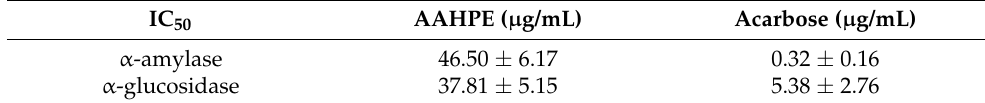
Figure 1. ( a ) α -amylase and ( b ) α -glucosidase inhibitory activity of AAHPE, using acarbose as a positive control (10–250 µ g/mL). Values are expressed as the mean ± SD ( n = 3), **** p < 0.0001 compared with the control. Table 1. The IC 50 inhibitory effect of AAHPE and acarbose on the α -amylase and α -glucosidase